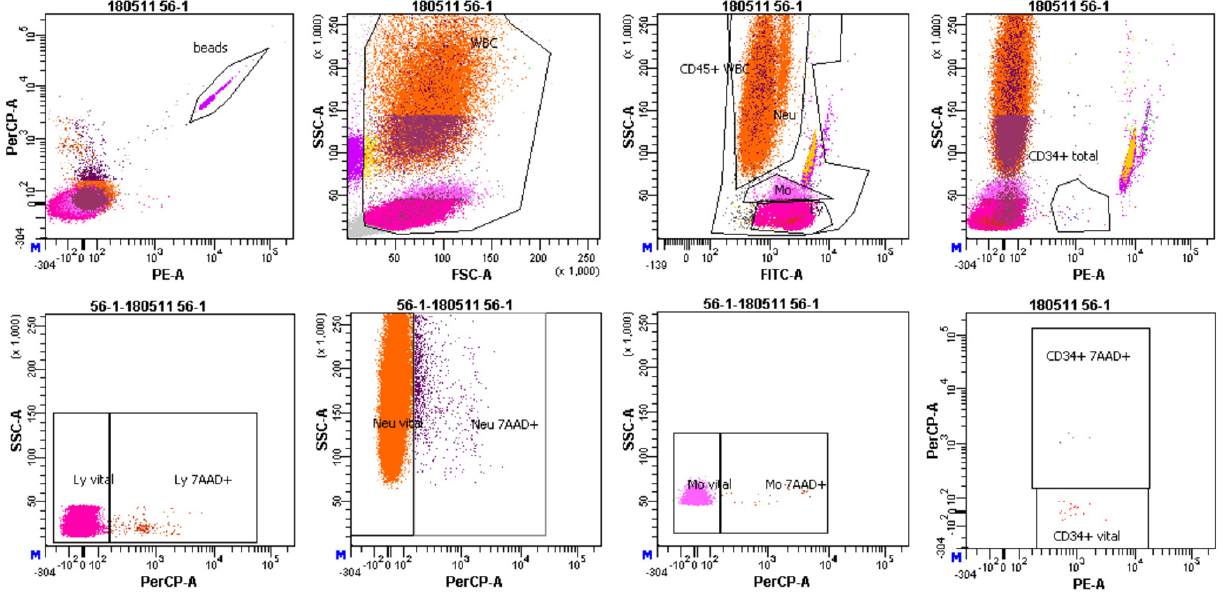
Figure 3. Representative image of FACS gating. First, white blood cells (WBCs) were gated. After- wards, lymphocytes (Ly), monocytes (Mo) and neutrophils (Neu) were gated according to CD45 expression as observed in the FITC-A fluorescent channel. In the next step, CD34+ hematopoietic stem/progenitor cells were gated according to the expression of CD34 antibody as observed in the PE channel. Lastly, percentage of late/apoptotic cells (7AAD+), as shown in PerCP—a fluorescent channel was assessed in all cell populations.